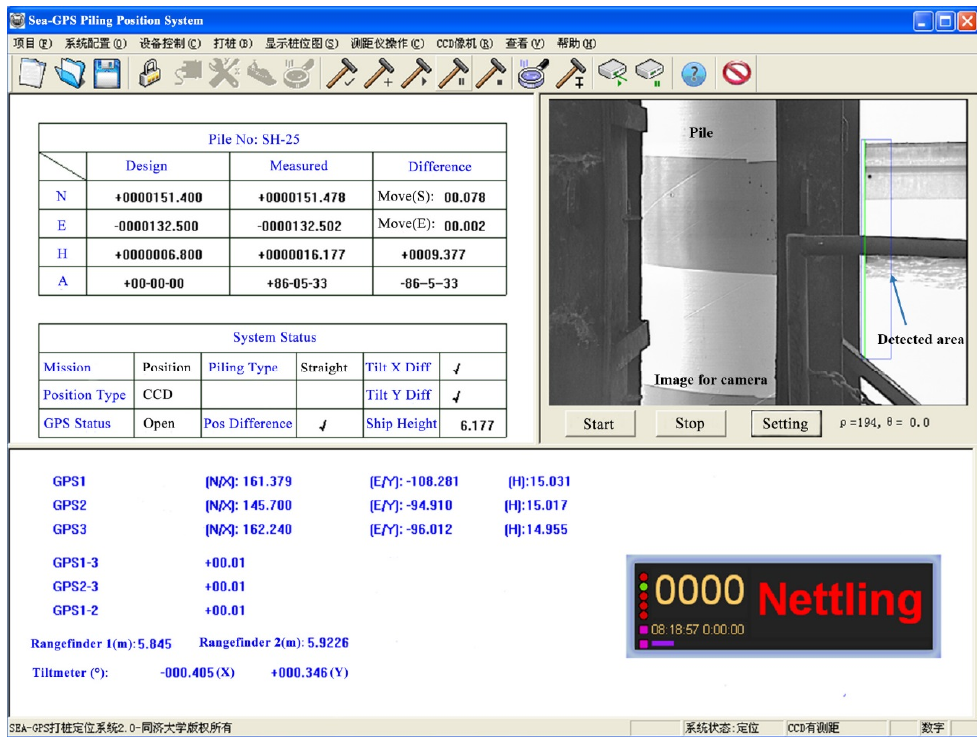
Figure 19. Software main interface using multi-sensor integration positioning model.